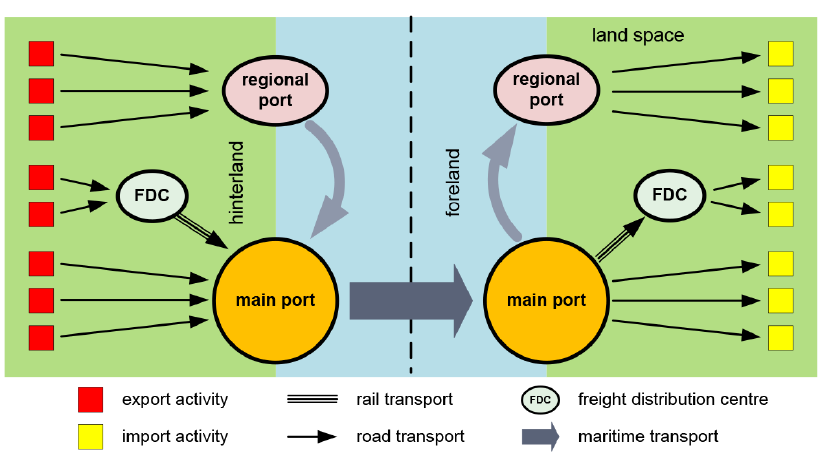
Figure 1. Hinterland transportation (Korea Maritime Institute,